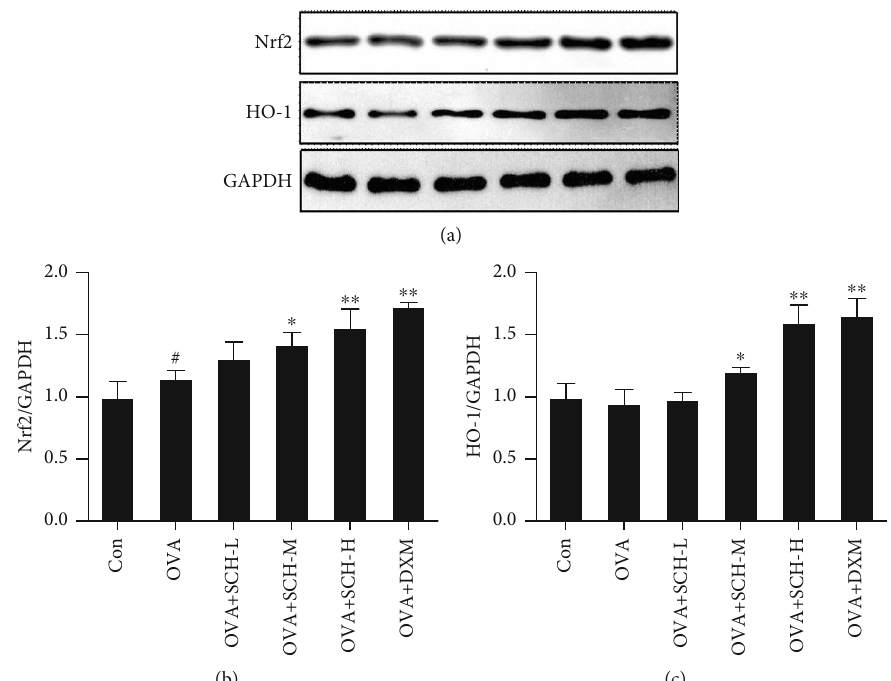
Figure 9: E ff ect of SCH on the activation of the Nrf2 pathway. (a) The expression of the HO-1 and Nrf2 proteins was analyzed using Western blotting. (b and c) Quanti fi cation of the relative density of HO-1 and Nrf2. Data are presented as the means ± SD ; n = 4 . # p < 0 : 05 compared with the control group; ∗∗ p < 0 : 01 and ∗ p < 0 : 05 compared with the OVA